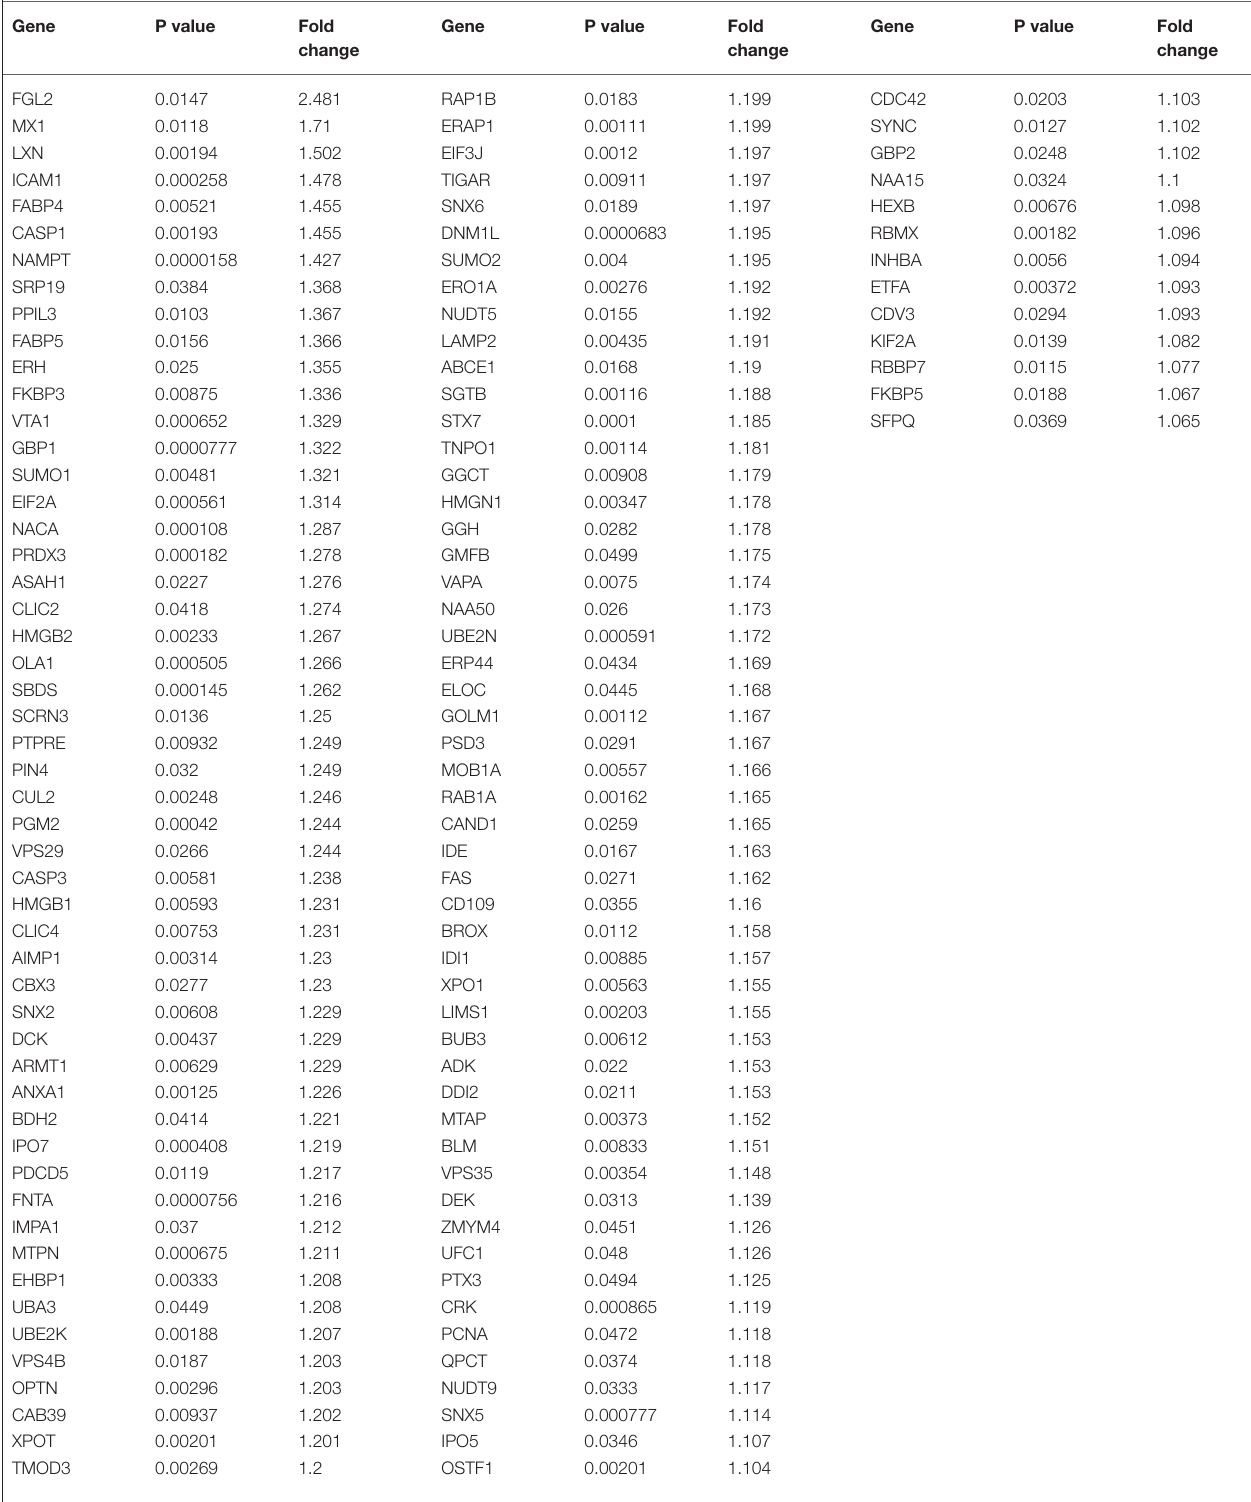
(C) Secretomes (Caspase 4 dependent): LPI treated HAECs vs Control